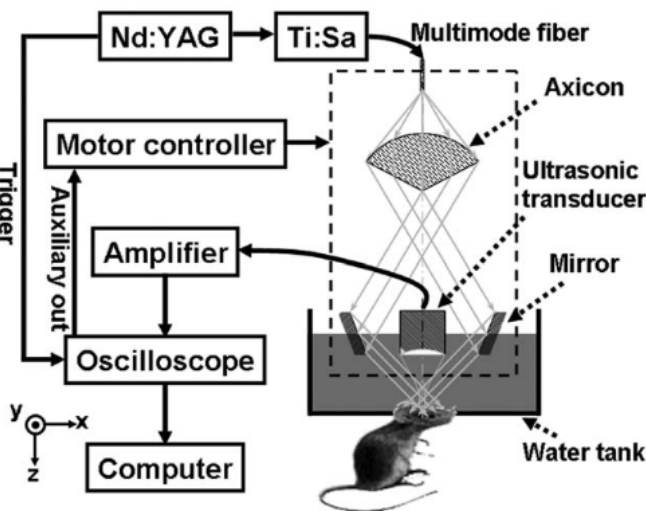
Figure 11. Schematic of the photoacoustic microscope for nanoshell imaging: Ti:Sa, Ti:sapphire. Reprinted from Li et al., J. Biomed. Opt., 2009, 14: 010507 [27], with permission from the Optical Society of America.